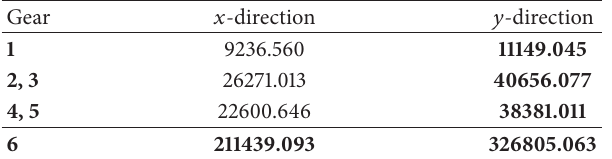
Table 2: Equivalent supporting